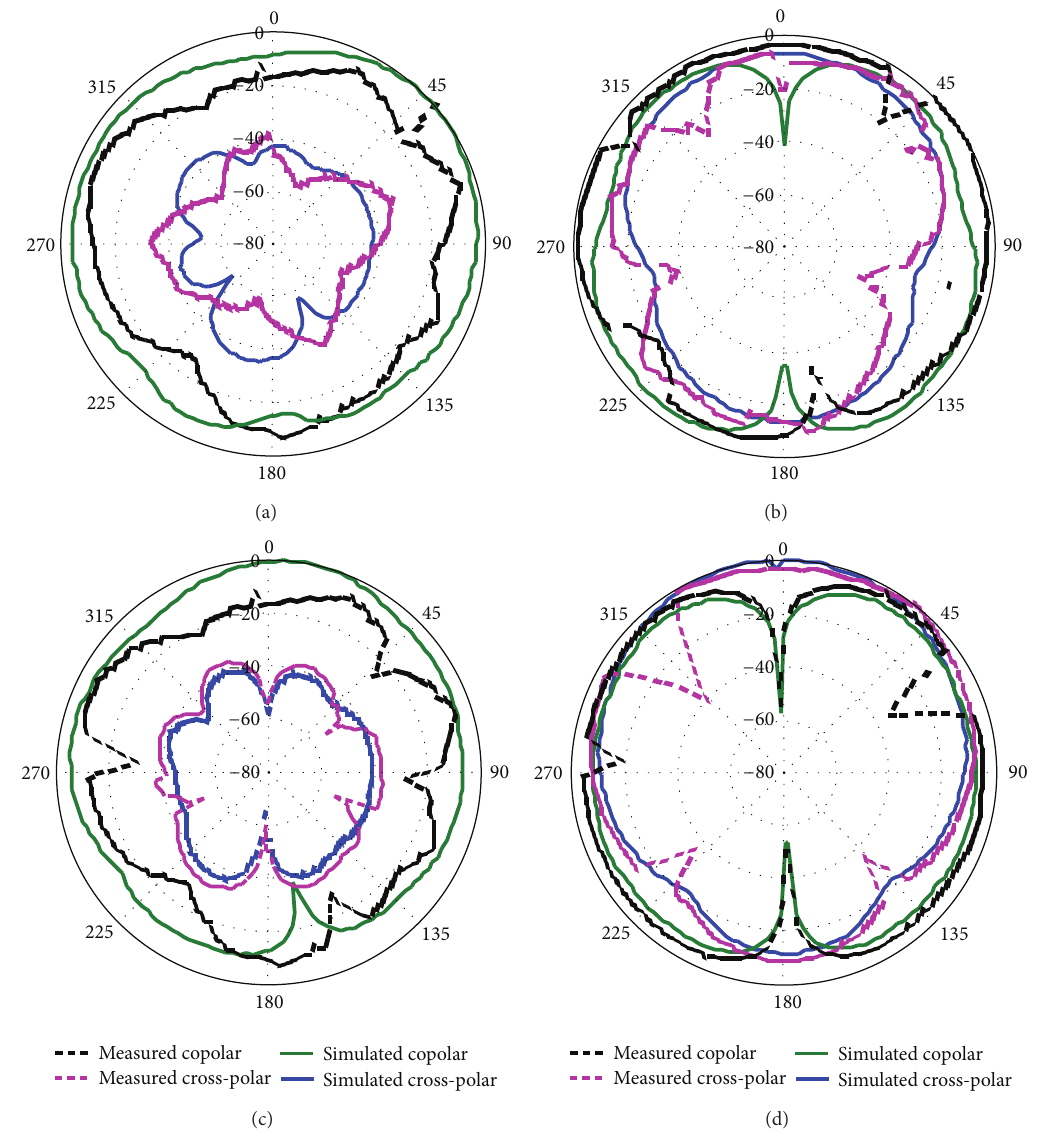
Figure 15: Measured radiation pattern of the proposed antenna: (a) E-plane at 15.46 GHz, (b) H-plane at 15.46GHz, (c) E-plane at 20.27 GHz, (d) H-plane 20.27